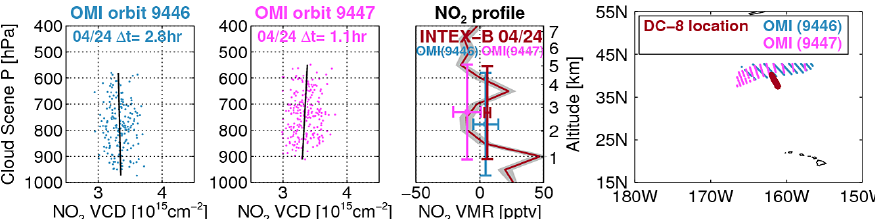
Figure B3. Similar to Fig. 5, but showing an example of variation in OMI NO 2 VMRs over two adjacent orbits (1.5h time difference) at the same location north of Hawaii,